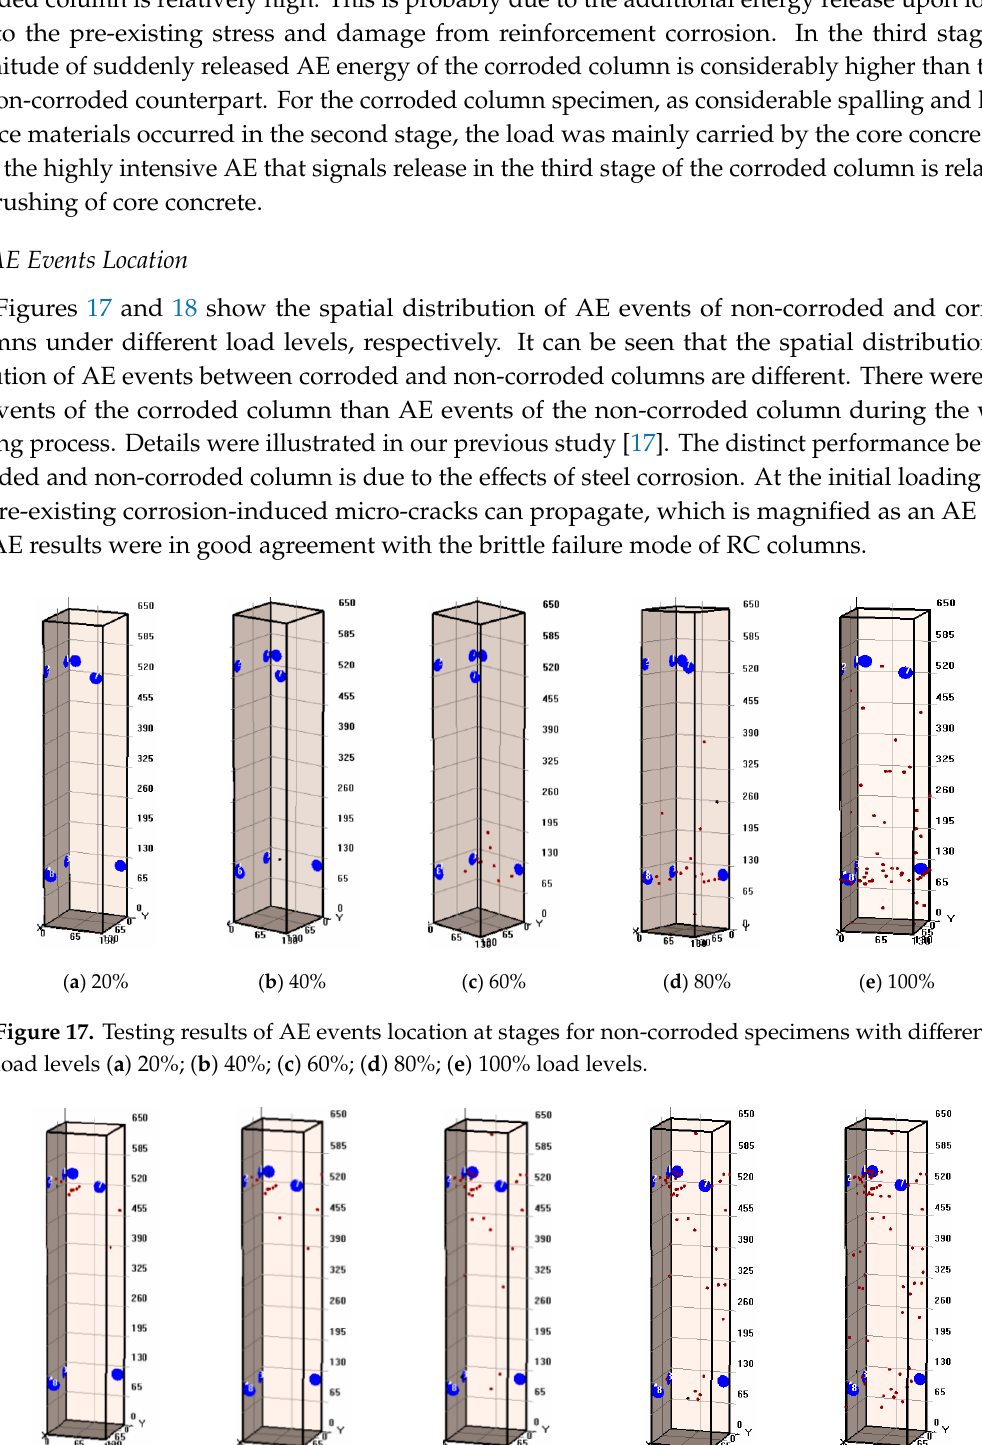
Figure 16. Correlation between AE cumulative energy and loads.